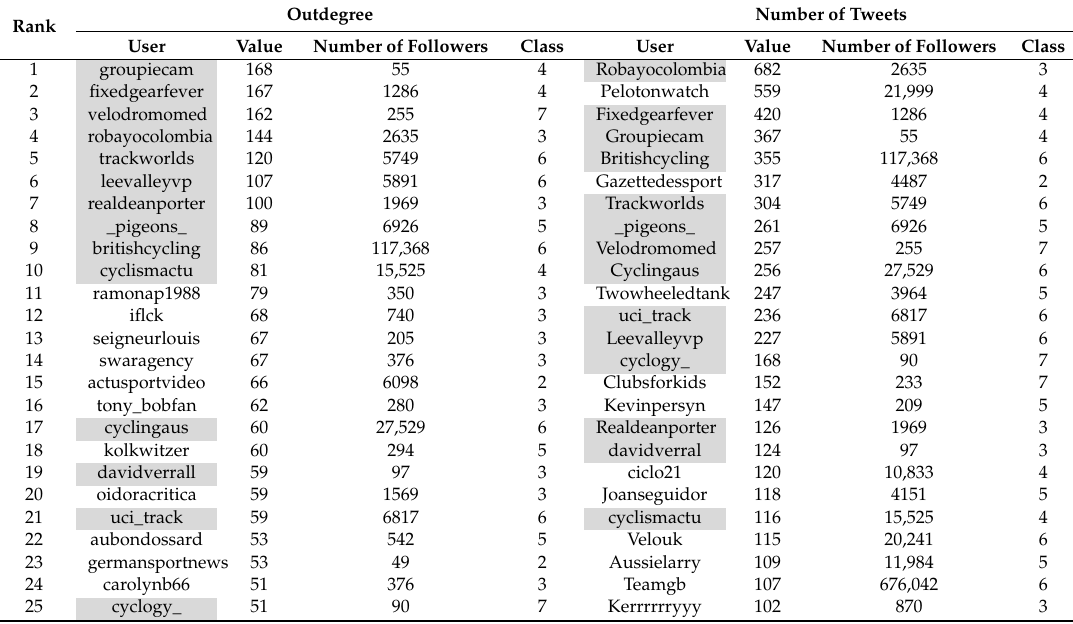
Table 4. Top 25 users by